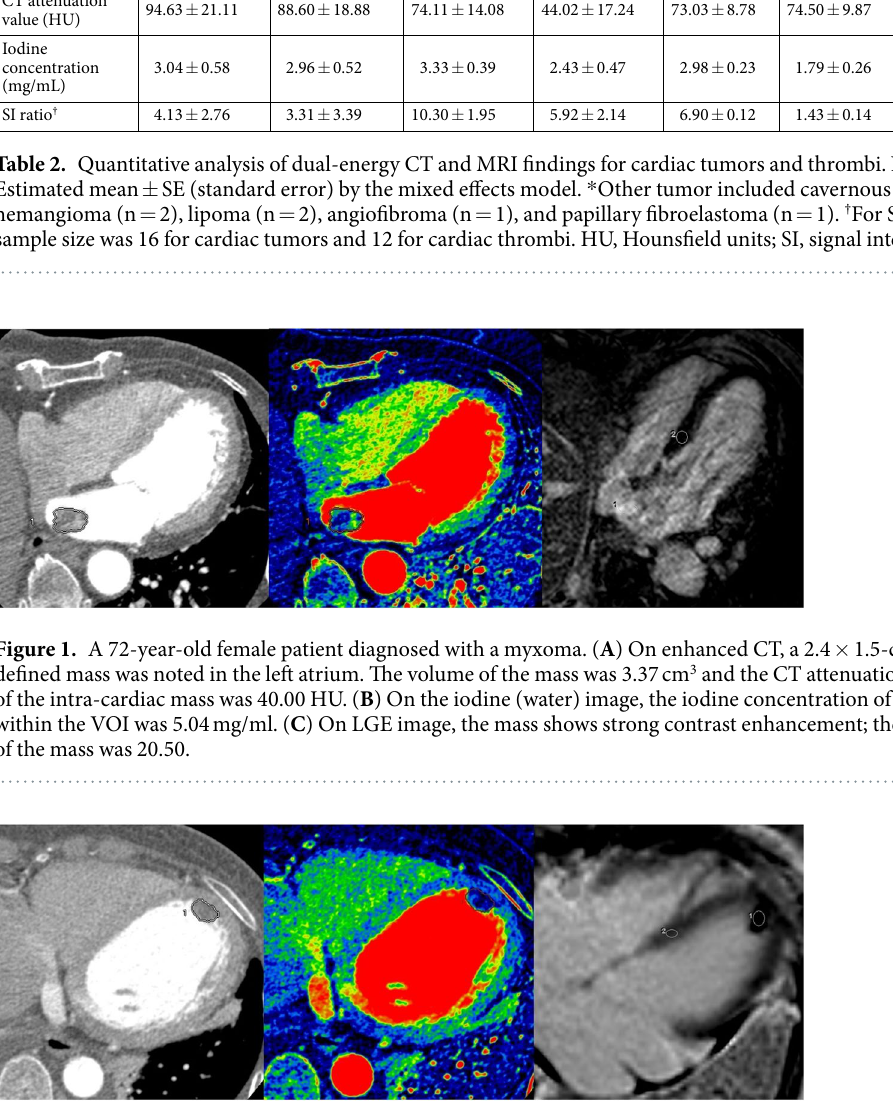
Figure 2. A 53-year-old female patient diagnosed with a thrombus. ( A ) On enhanced CT, a 1.5 × 1.0-cm well-defined mass was noted in the apex of left ventricle. The volume of the mass was 0.81 cm 3 and the CT attenuation value of the intra-cardiac mass was 59.0 HU. ( B ) On the iodine (water) image, the iodine concentration within the VOI was 1.05 mg/ml. ( C ) On LGE image, the mass shows dark signal intensity without enhancement; the SI ratio of the mass was